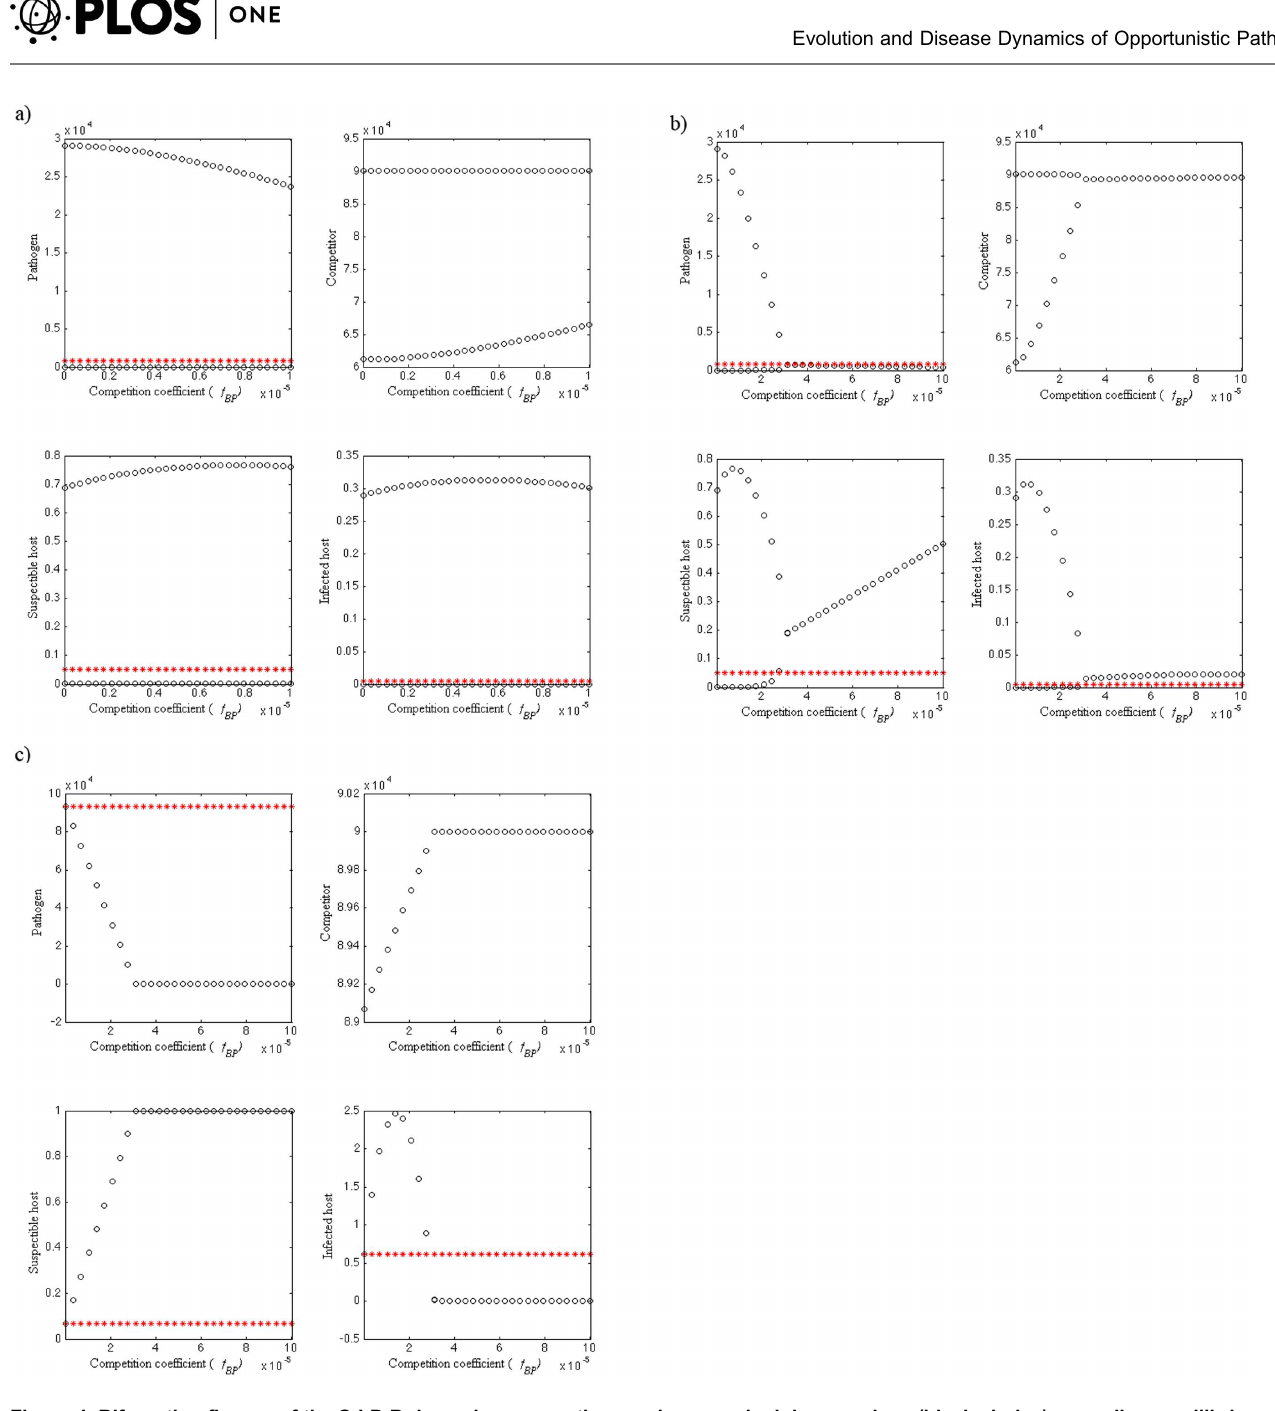
Figure 4. Bifurcation figures of the S-I-P-B dynamics, presenting maximum and minimum values (black circles), as well as equilibrium densities when competitor ( B ) is not present (red stars) of susceptible host ( S ), pathogen ( P ) and non-pathogenic ( B ) population densities in different combinations of the competition coefficient ( f BP ) parameter values. a) Dynamics are cyclic when susceptible host growth rate ( r S ) is 0.01, outside-host growth rate of pathogen ( r P ) is 0.05 and f BP varies between 0 and 10 2 5 . b) When r S 5 0.01, r P 5 0.05 and f BP 5 10 2 7 –10 2 4 , dynamics are first cyclic and the densities of P , S and I are decreasing as f BP and the density of B increase. As f BP increases further, pathogen population stabilizes close to zero and the density of S starts to increase. c) When r S 5 1, r P 5 0.5, f PB 5 10 2 7 and f BP 5 10 2 8 –10 2 4 , the coexistence dynamics are locally stable. As f BP increases, pathogen goes extinct. The parameter values used are shown in Table